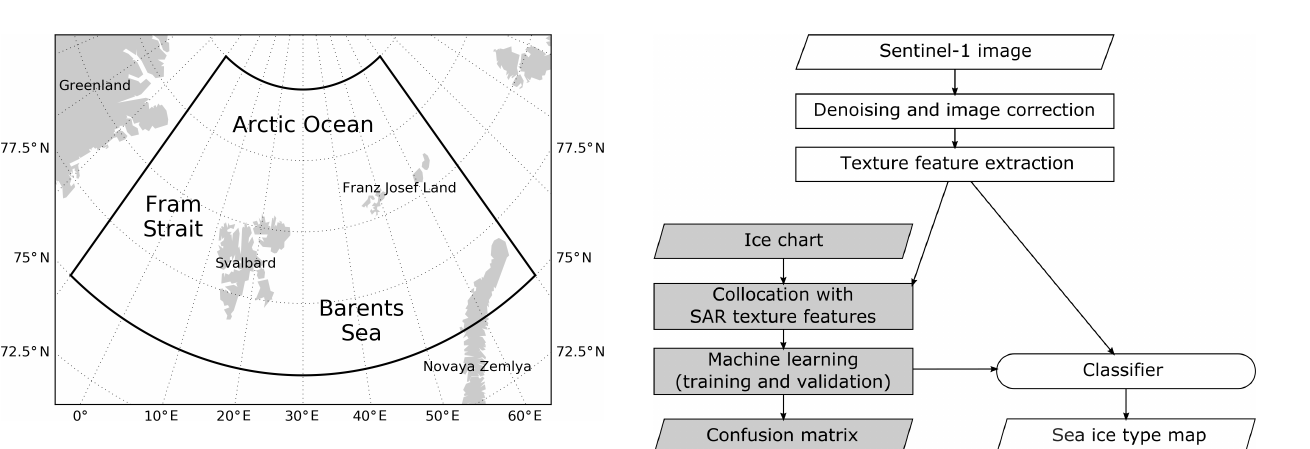
Figure 1. Study area.